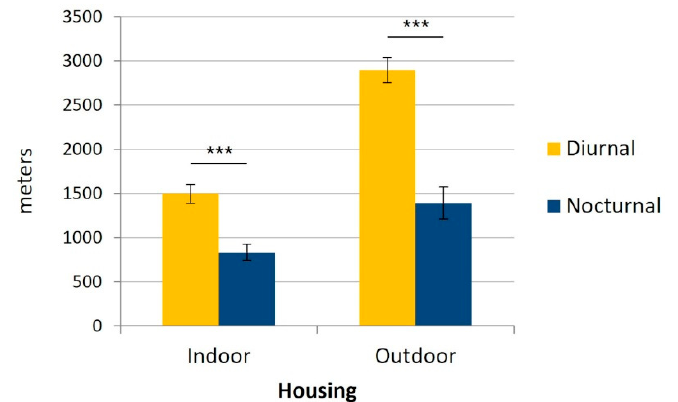
Figure 5. Mean daily nocturnal and diurnal distance (m) covered by the cats according to their housing conditions (indoors (n = 15) versus outdoors (n = 8)). Error bars represent standard errors, (***) indicates p < 0.001.